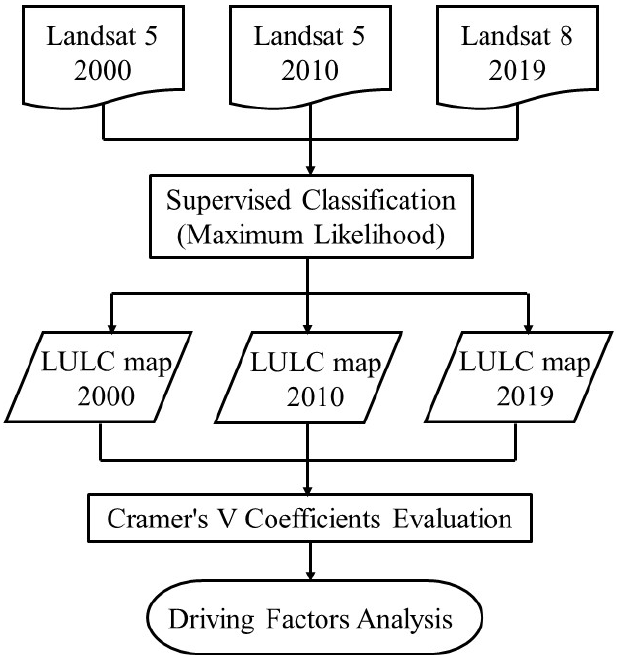
Figure 1. A flowchart for the methodologies used in this study.